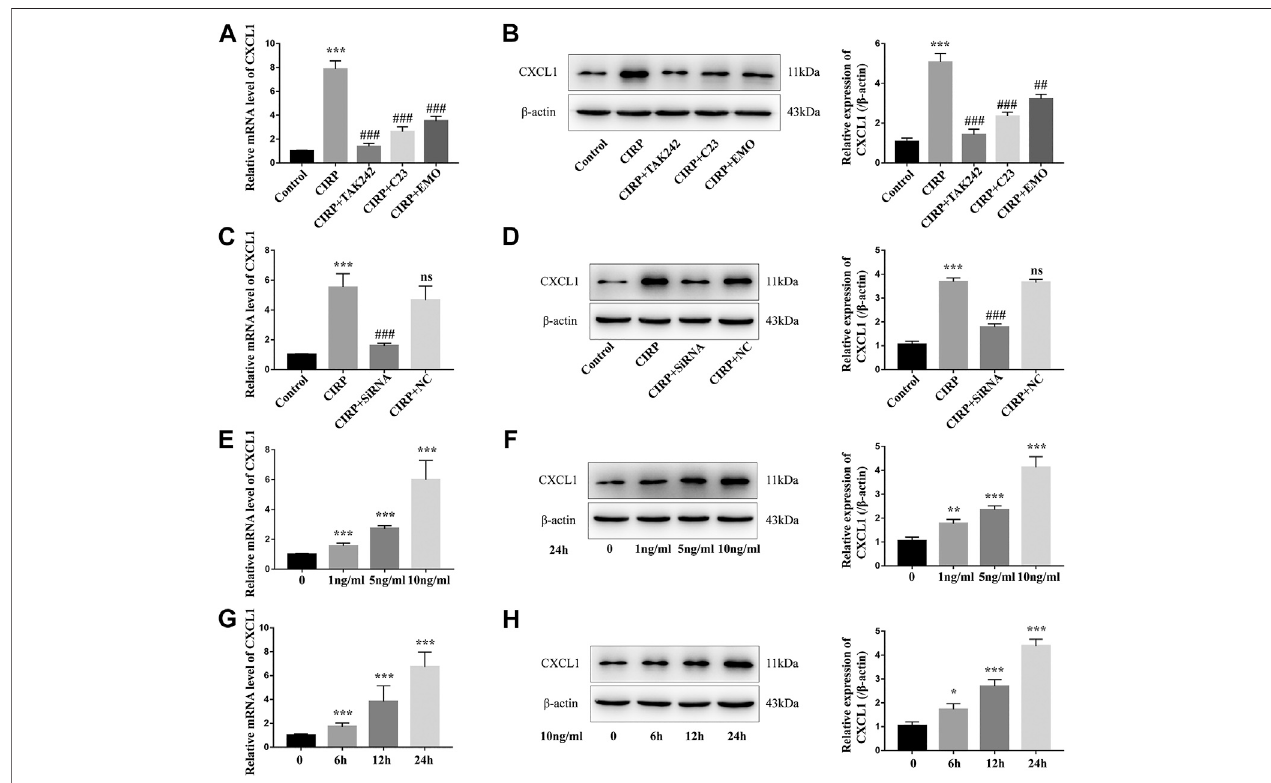
FIGURE 6 | Treatment with emodin mitigates the CIRP-induced IL-1 β -dependent CXCL1 expression in NR8383 cells. (A) Quantitative RT-PCR analysis of the relative levels of CXCL1 to the control GAPDH mRNA transcripts in NR8383 cells. (B) Western blot analysis of the relative levels of CXCL1 to the control β -actin expression in NR8383 cells. (C and D) CIRP only induced very lower levels of CXCL1 expression in the IL-1 β silencing NR8383 cells. (E – H) IL-1 β enhanced CXCL1 expression in NR8383 cells in a dose- and time-dependent manner. The data are representative images or expressed as mean ± SD of each group of cells from three separate experiments; * p < 0.05, ** p < 0.01, *** p < 0.001 vs. the Control group. ## p < 0.01, ### p < 0.001 vs. the CIRP group. NS, not signi fi